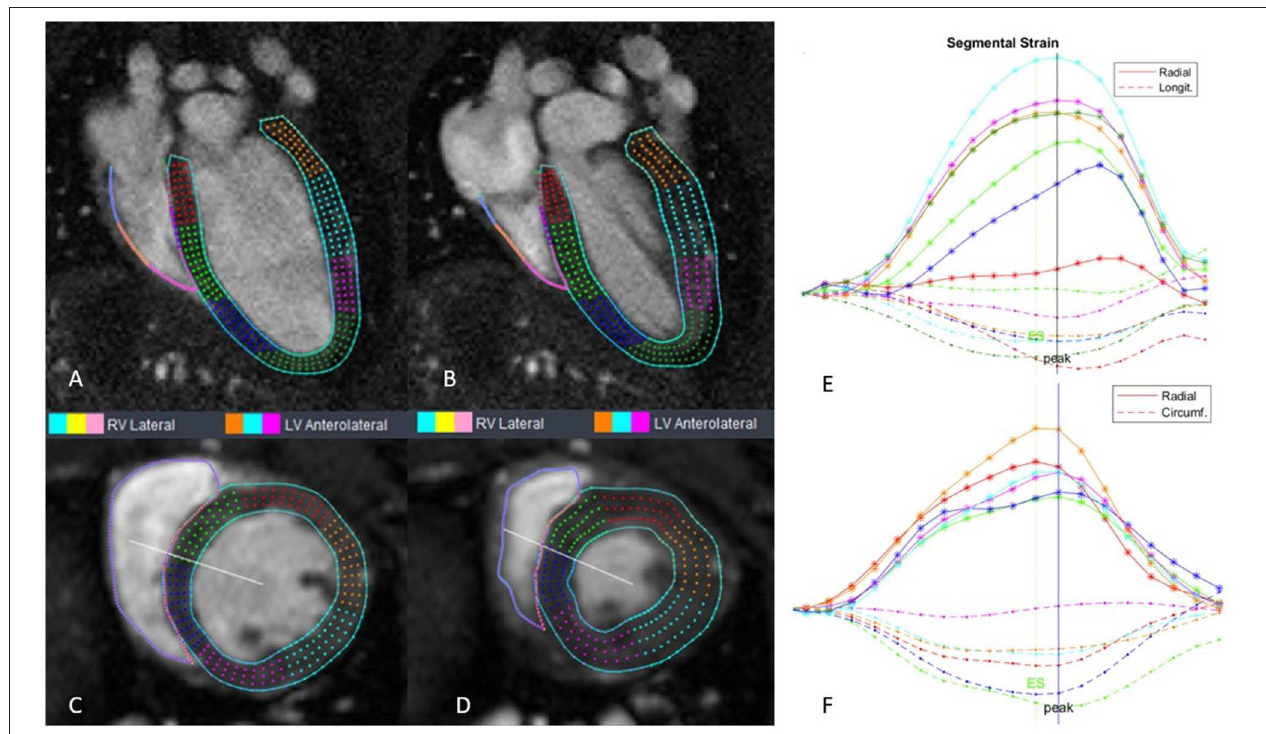
FIGURE 5 | Cine CMR images with CMR-FT myocardial strain curves in mouse. (A) 4-chamber at end-diastole; (B) 4-chamber at end-systole; (C) short axis at the end-diastole; (D) short axis at the end-systole; (E) segmental strain for 4-chamber; (F) segmental strain for short axis. Stain analysis was done using Segment v3.0 R7732